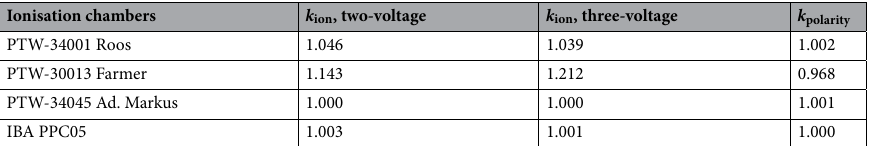
Table 3. Correction factors for ionisation chamber types at an averaged dose rate of ~ 63 Gy s −1 for an applied voltage of 400 V (collecting negative